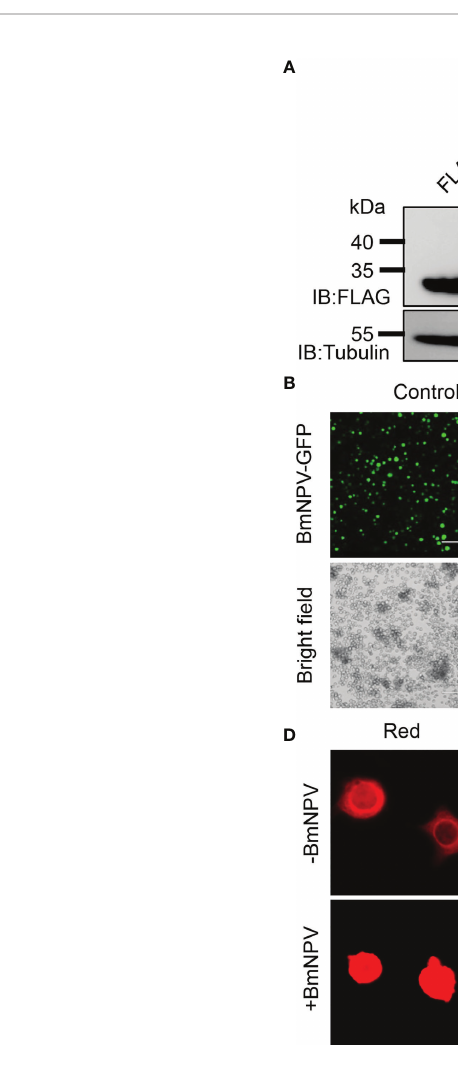
FIGURE 4 | Stabilization of Bombyx mori translationally controlled tumor protein ( BmTCTP ) SUMOylation enhanced its antiviral immunity. (A) Plasmids expressing FLAG-TCTP and FLAG-TCTP-SMT3 were transfected into the silkworm BmN cells, and then cells were collected after 72 h. Proteins from FLAG-TCTP and FLAG- TCTP-SMT3 were detected by anti-FLAG and anti-Tubulin antibodies. (B) Plasmids as indicated were transfected into the silkworm BmN cells, and then cells were infected with Bombyx mori nucleopolyhedrovirus (BmNPV)-GFP for 72 h. Fluorescence microscopy was used to observe the viral amounts. Scale bar, 400 m m. (C) The viral DNA contents were detected by qRT-PCR analysis of the BmNPV GP41 gene. The expression of BmGAPDH gene was used as an internal control. The data presented are the means ± SD (n = 3). For the signi fi cant analysis: *P < 0.05 and ***P < 0.001. (D) Red-TCTP-SMT3 was transfected into the silkworm BmN cells, and then cells were infected with or without BmNPV-GFP for 72 h. Subcellular localization of Red-TCTP-SMT3 was determined by fl uorescence (red), and the nuclear DNA was counterstained with 4 ’ ,6-diamidino-2-phenylindole (DAPI) (blue). Scale bar, 10 m